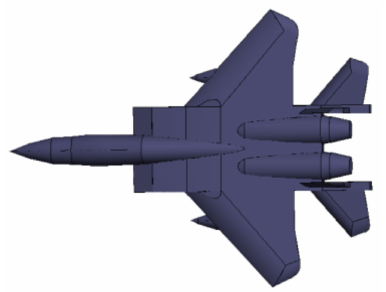
Figure 17. Top view of the model aircraft.